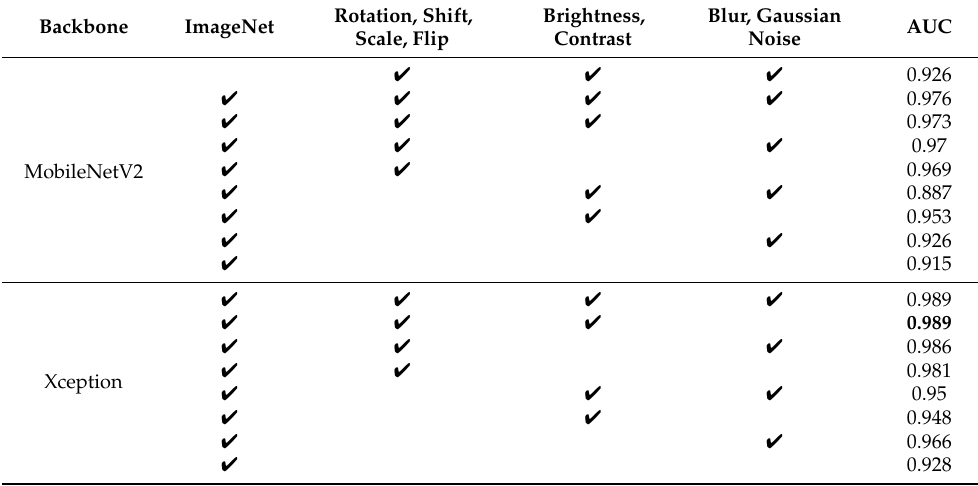
Table 1. Summary of suspicious frame selection results for different architectures (MobileNetV2 and Xception) and different combinations of augmentation.